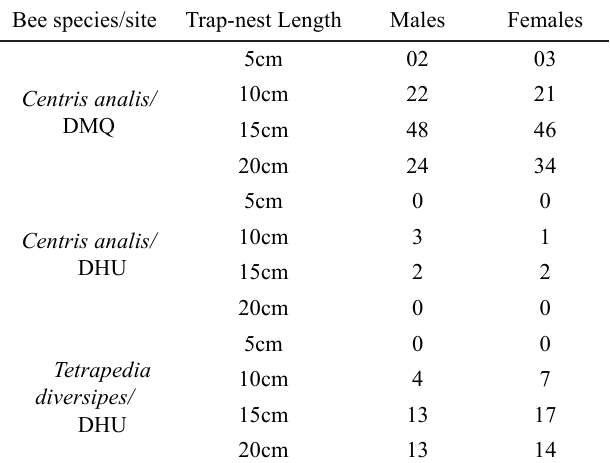
Table 3 . Number of males and females of Centris analis and Tetrapedia diversipes produced in trap-nests with different lengths.